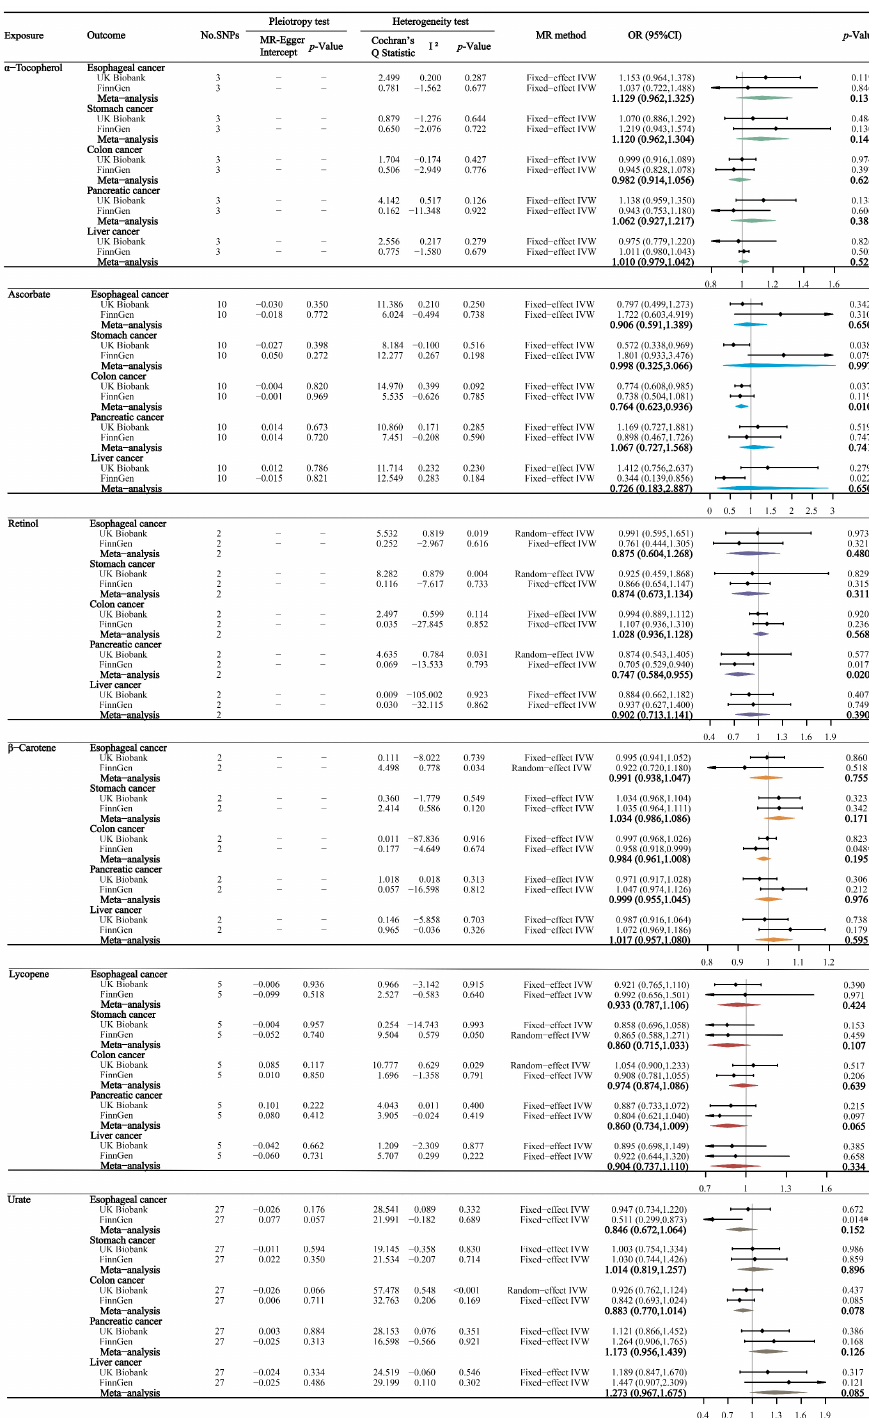
Figure 2. The main MR analyses results of the causal effects of absolute circulating antioxidant levels on five digestive system cancers. If there was significant heterogeneity ( p -value of Cochran (cid:48) s Q Statistic < 0.05) we used the random-effect IVW model, otherwise we used the fixed-effect IVW model. The odds ratios were scaled per 10% unit increase in log-transformed α -tocopherol values, per unit increase in ascorbate, per 10% unit increase in ln-transformed retinol, per 10% unit increase in ln-transformed β -carotene, per unit increase in lycopene, and per unit increase in urate. Statistical significance was defined as Bonferroni-corrected threshold of p -value < 0.01 (0.05/5), and p -value between 0.01 and 0.05 was considered suggestive evidence (*) of